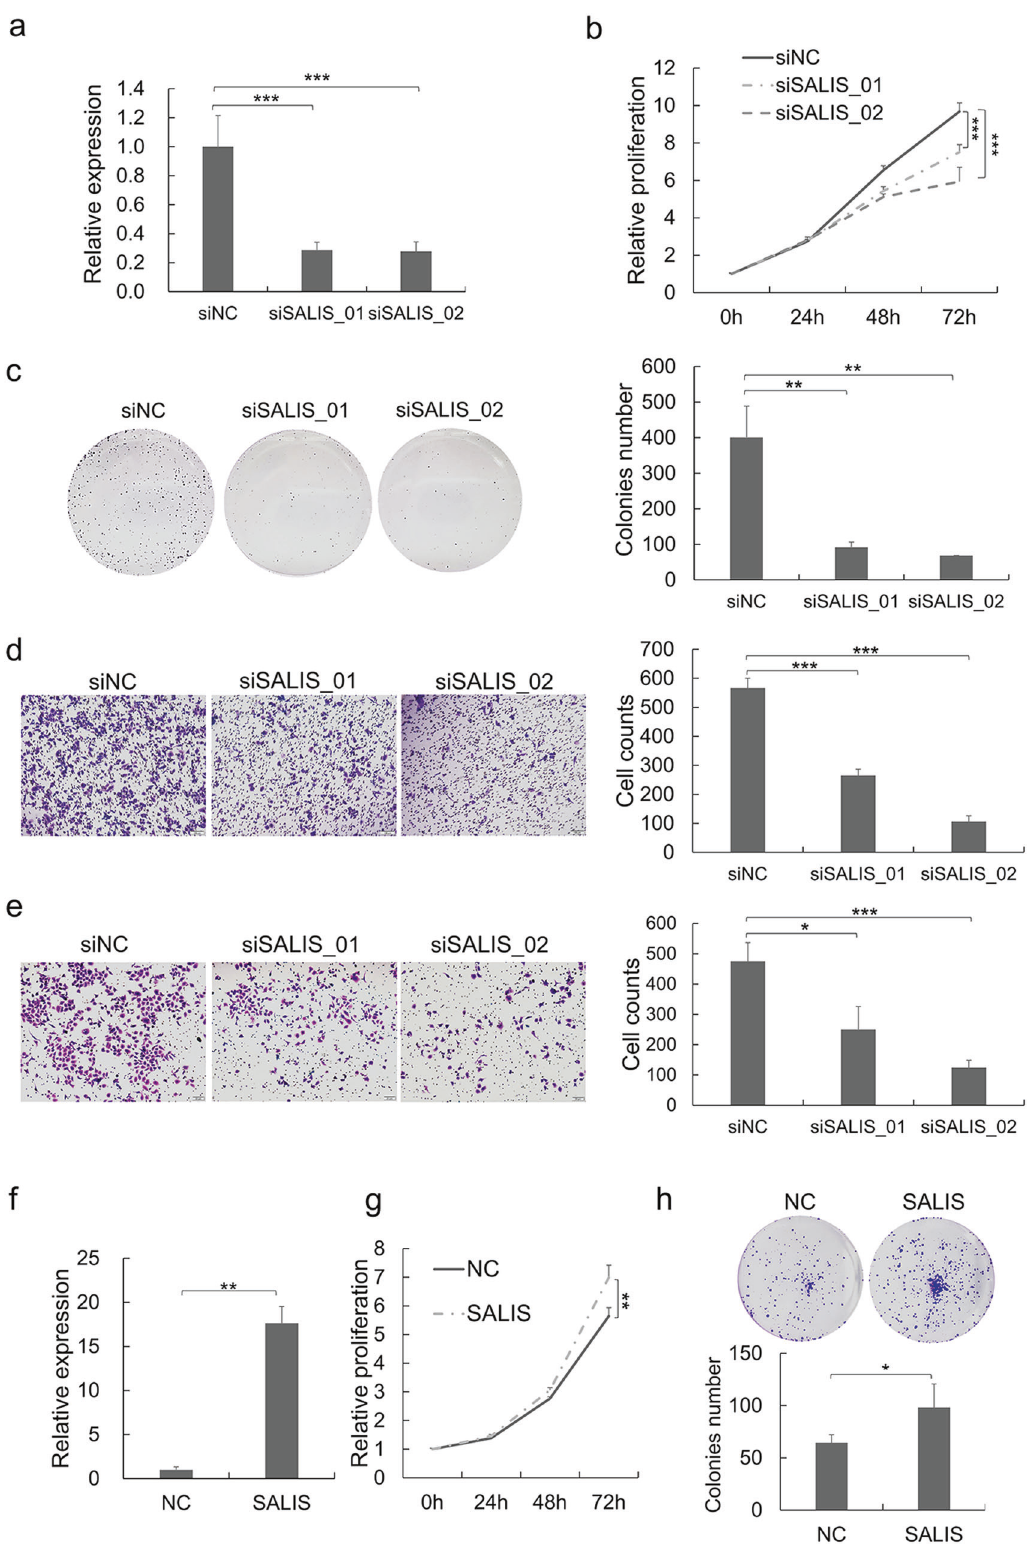
Fig. 2 SALIS promotes cell proliferation, migration, and invasiveness in HCC cells. a SALIS RNA expression was detected by qPCR after knockdown of SALIS by siRNAs in HepG2 cells. Measurement of cell proliferation by CCK-8 assay ( b ), colony formation assay ( c ), transwell migration assay ( d ), and matrigel invasiveness measurement ( e ) were performed in HepG2 cells treated with siSALIS treatment. f SALIS RNA expression was detected by qPCR after overexpression of SALIS in HepG2 cells. Measurements of cell proliferation by CCK-8 assay ( g ), colony formation assay ( h ) were performed in HepG2 cells overexpressing SALIS. Data are plotted as the means ± s.d. n = 3. Scale bar: 20 μ M. * P < 0.05, ** P < 0.01, *** P < 0.001. Cell Death and Disease (2022)